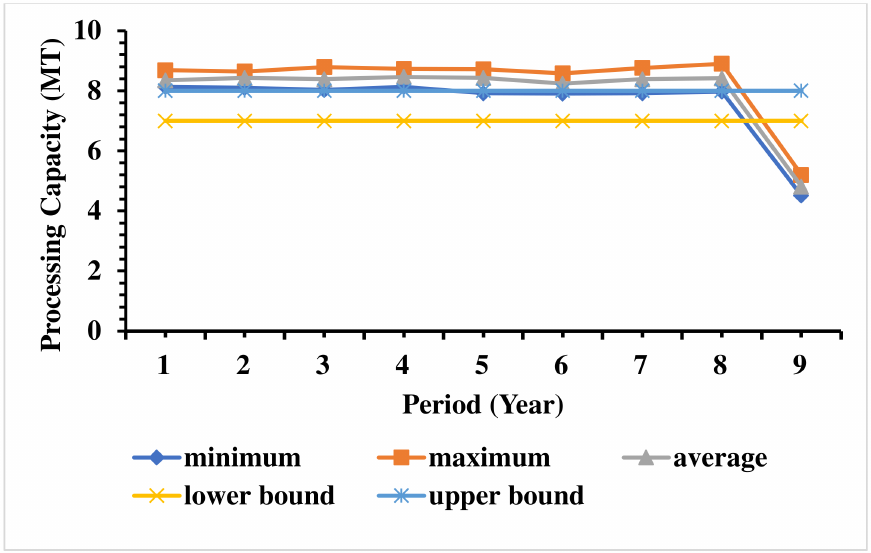
Figure 3. Ore production from the study mine using the proposed